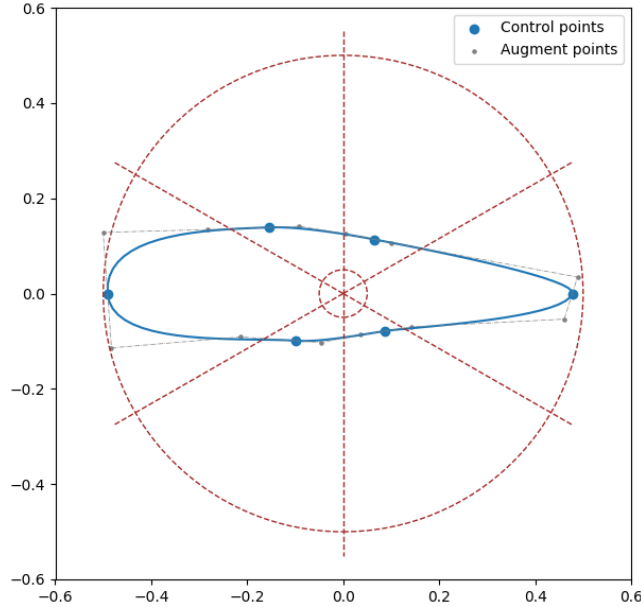
Figure 1. An illustration of a valid airfoil shape with six control points. The dashed circles denote the minimum and maximum radius for each point. The dashed rays split the annulus into N equal